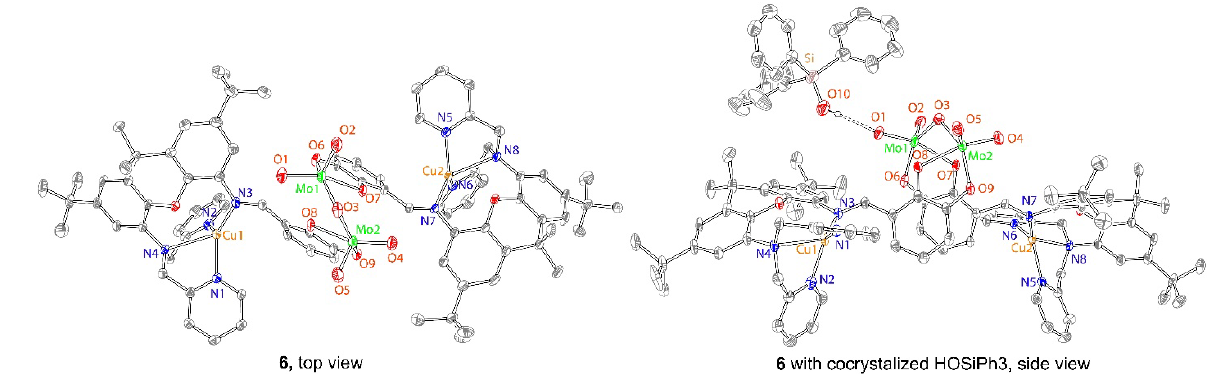
Figure 3. X-ray structure of 6 , 40% probability ellipsoids. Left: top view, without co-crystallized HOSiPh 3 molecule. Right: side view, showing H-bonding between one of the basal oxos (O1) and the co-crystallized HOSiPh 3 molecule. H atoms, co-crystallized acetonitrile molecules, and an alternative conformation for one of the tert-butyl groups were omitted for clarity. Selected bond distances: Mo1 O1 1.721(3), Mo1 O2 1.696(3), Mo1 O3 1.919(3), Mo2 O4 1.711(3), Mo2 O5 1.706(3), O1–O10 2.769(4) Å.